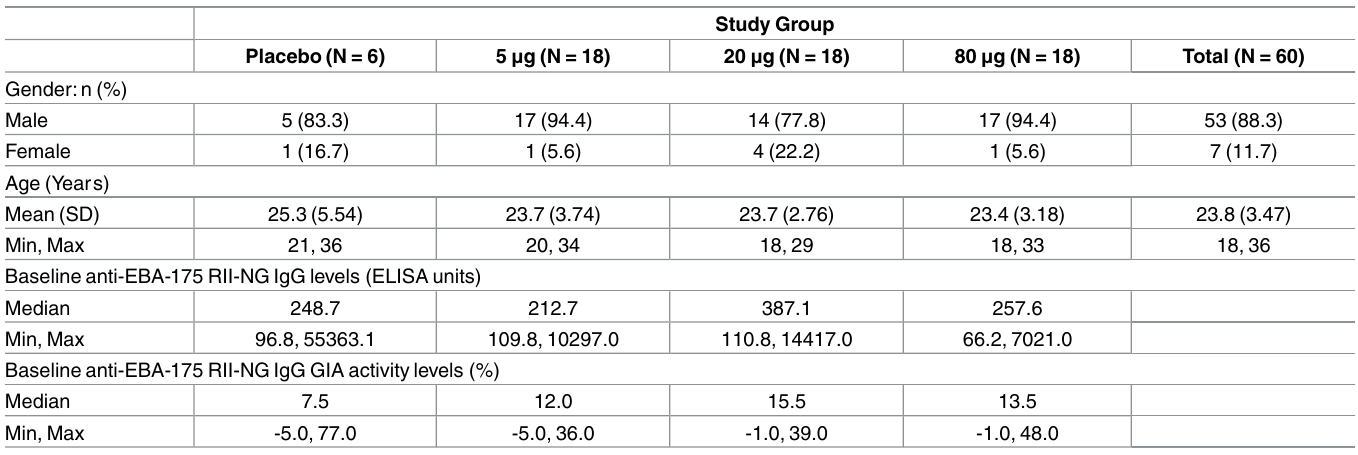
Table 1. Demographic and baselinecharacteristicsby dose of study population.